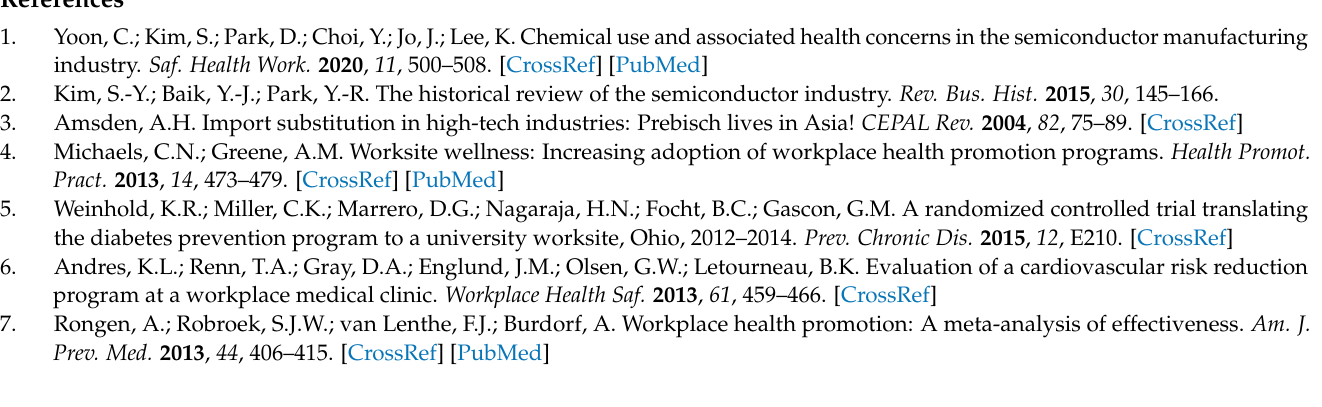
Table S2: Demographic characteristics of employees at semiconductor/liquid crystal display (LCD) workplaces by risk group of cardiovascular diseases, Table S3: Participation in health promotion program of employees of semiconductor/liquid crystal display (LCD) workplace by their health risk